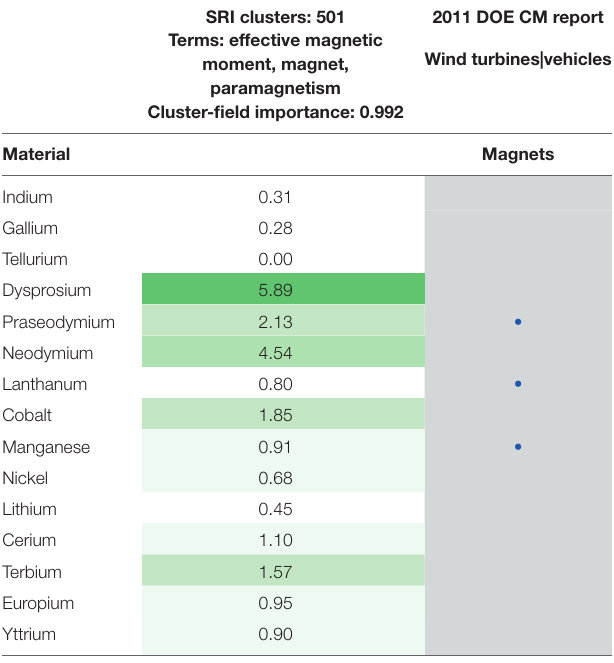
Table 2 | Materials/application pairing matrix comparing the results from our methodology with the Department of Energy (DOE)’s CM strategy report for wind turbines and vehicle technologies, and magnet